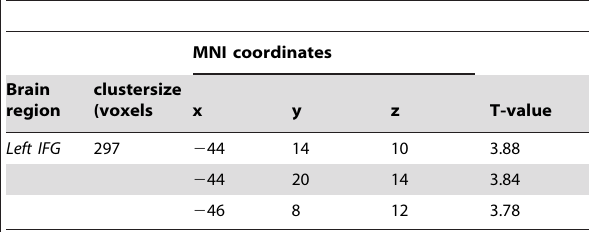
Table 3. Peak activations for PP . HC for the ToM contrast HI . LI. For HC . PP no significant peak activations were